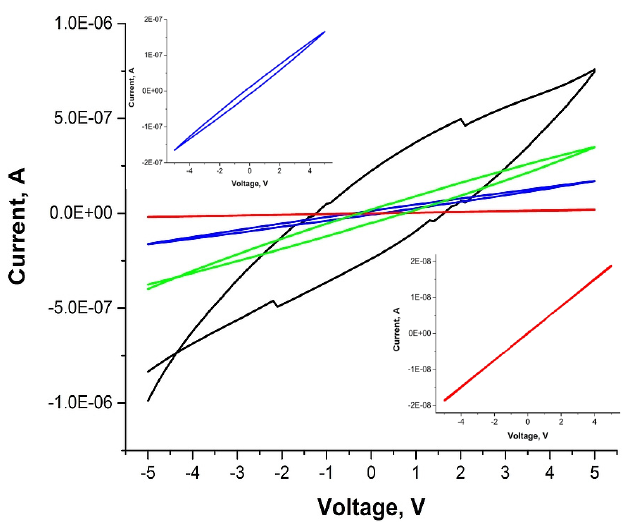
Figure 6. Current–voltage curves of low-MW P4VP/Py gel sample (thickness 230 mm, cross-section 5 × 5 mm) before irradiation (black curve); after irradiation at 254 nm for one hour and 10 h holding in the dark (green curve); after additional one-hour irradiation and holding the sample in the dark for 10 h (blue curve and upper inset); after the third one-hour irradiation and holding the sample in the dark for 10 h (red curve and lower inset). The sweep rate was 1.7 V/s.